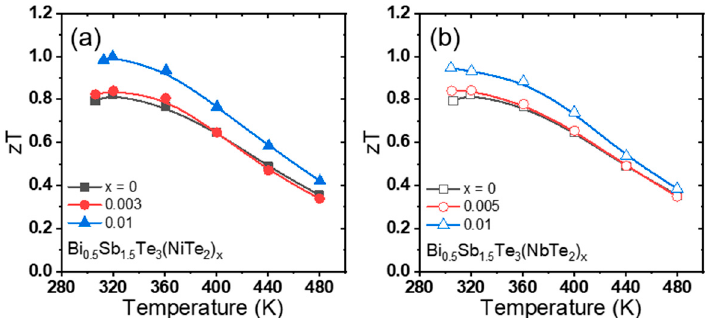
Figure 6. The zT values for ( a ) Bi 0.5 Sb 1.5 Te 3 (NiTe 2 ) x ( x = 0, 0.003, 0.01) and ( b ) Bi 0.5 Sb 1.5 Te 3 (NbTe 2 ) x ( x = 0, 0.005, 0.01). ( x = 0, 0.005,